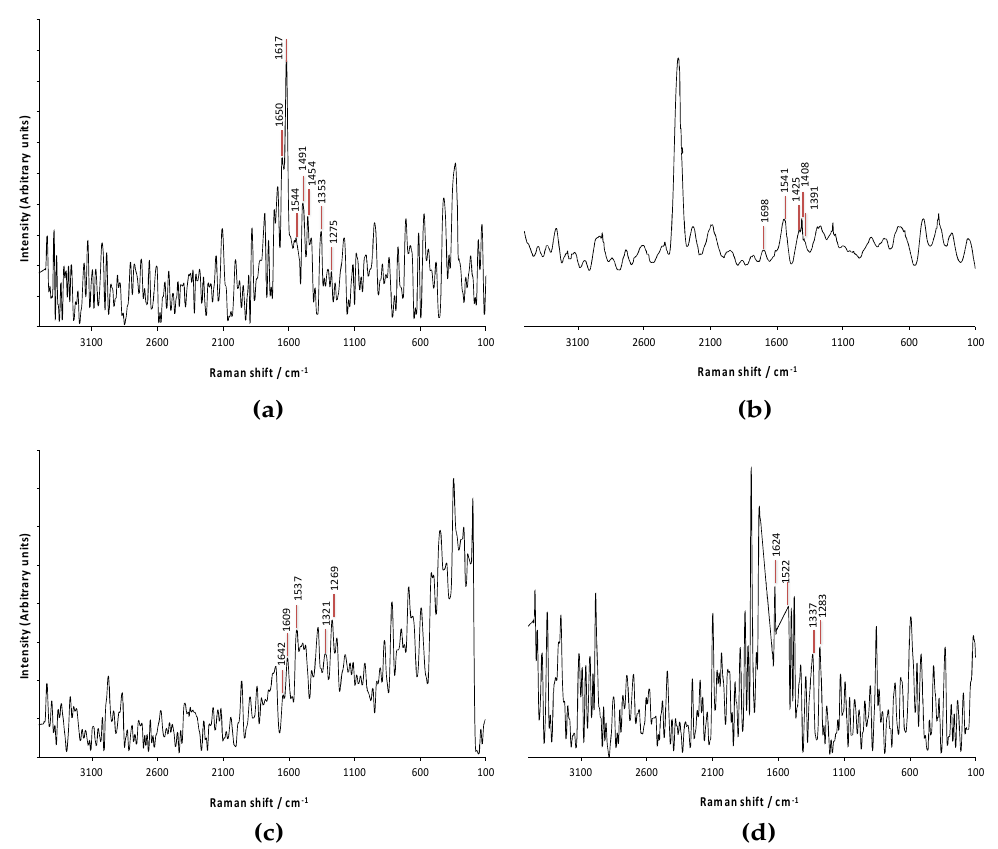
Figure 4. FT-Raman spectra of pacaya protein isolates ( a ) extracted from pacaya without thermal treatment; ( b ) extracted from pacaya under hydrothermal processing; ( c ) extracted from pacaya via steaming at an elevated temperature; ( d ) extracted from pacaya under microwave treatment.